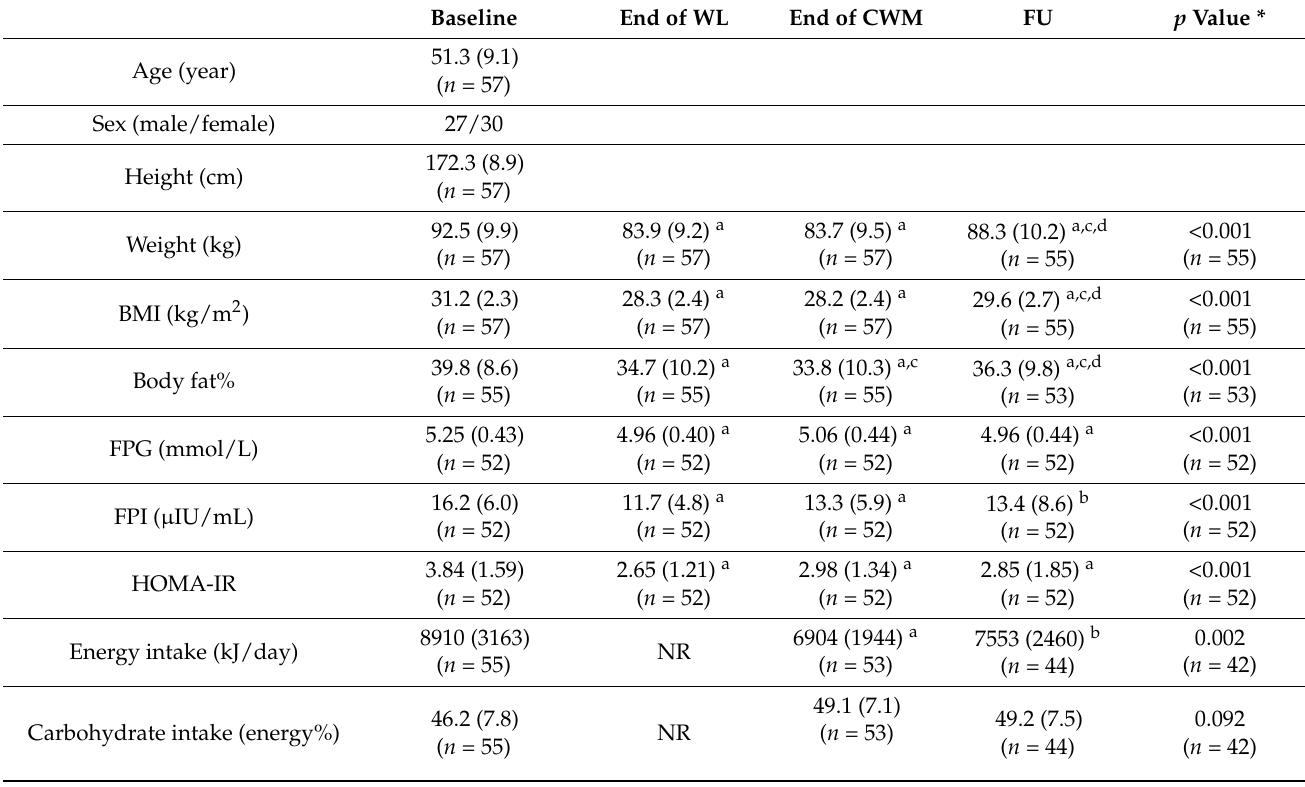
Table 1. Subject characteristics and anthropometrics, glucose homeostasis parameters, and dietary intakes (mean (SD)) at the different time points of the study (baseline, end of WL, end of CWM, and